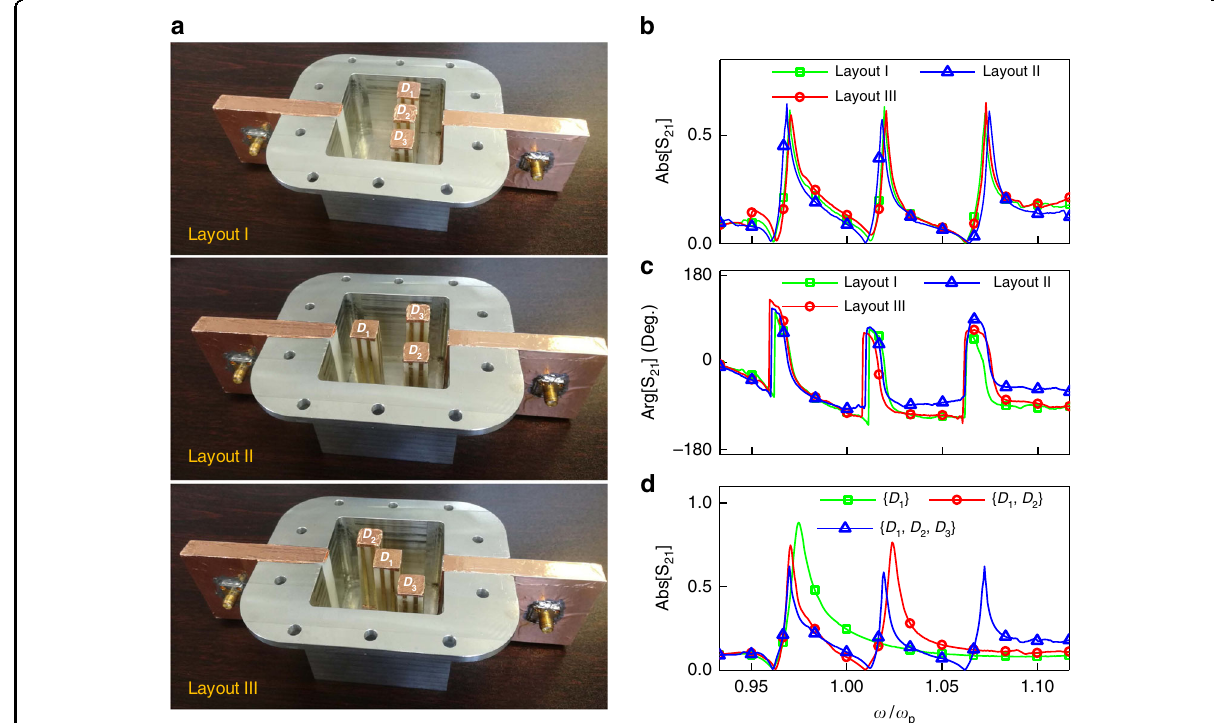
Fig. 4 Experimental veri fi cation. a The photograph of the experimental setup. Three cuboid ceramic blocks ( D 1 , D 2 , and D 3 ) with permittivity = 37 and cross-sectional areas of 0.122 λ ε 1 are arranged in the metallic cavity with a height h of 0.5 λ p and a cross-sectional area of 0.66 λ p ×0.5 λ p . The upper plate of the metallic cavity is not shown in the photographs. The doped ENZ cavity is connected to the feeding waveguides fi lled with Te fl on ( ε r = 2.1). Measured transmission amplitudes ( b ) and phases (after calibration) ( c ) for different spatial arrangements of the dopants in the cavity. d Measured transmission amplitude for different combinations of the dopants being